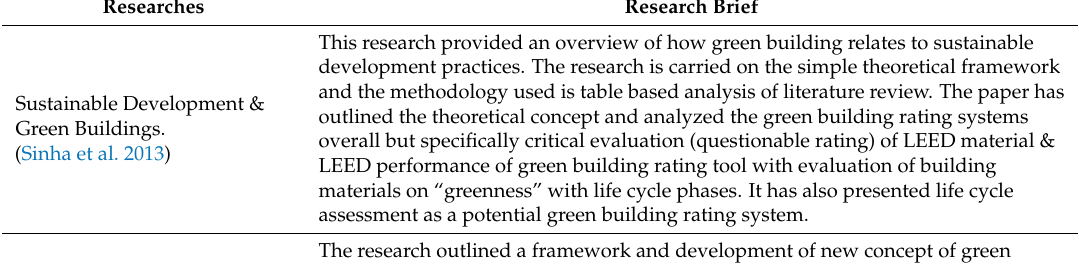
Table 3. Summarized Research Brief